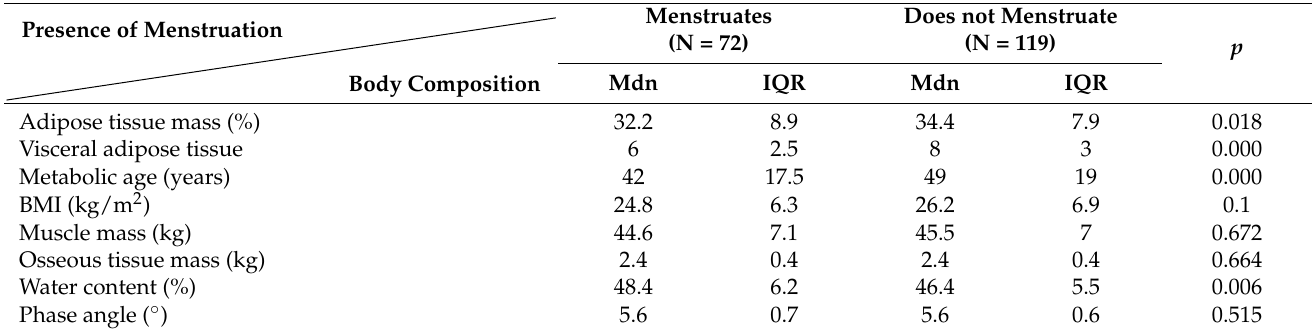
Table 7. Body composition analysis in relation to the presence of menstruation among the studied